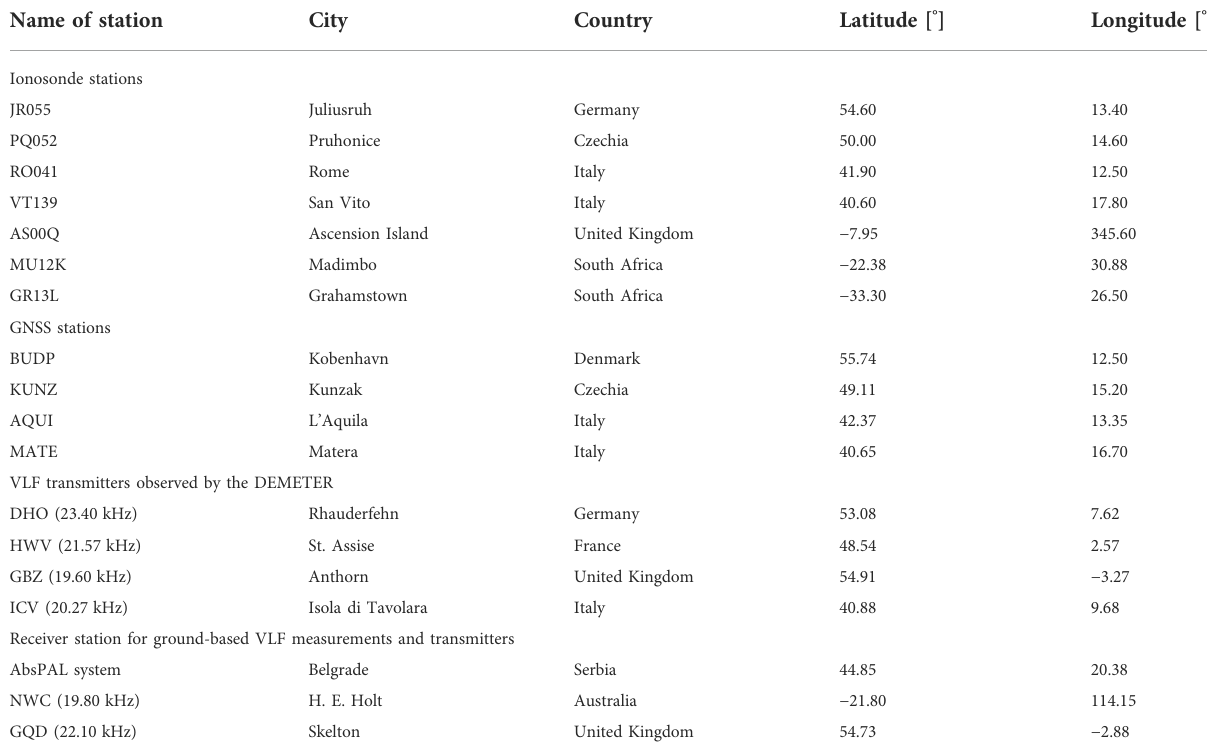
TABLE 1 The name, location and geographical coordinates of the stations used in this study. The transmitter frequency of the VLF stations are in brackets after the name of the station. The GCP for the ground-based VLF measurements are: 1,980 km for the GQD-BEL path and 11,980 km for the NWC-BEL